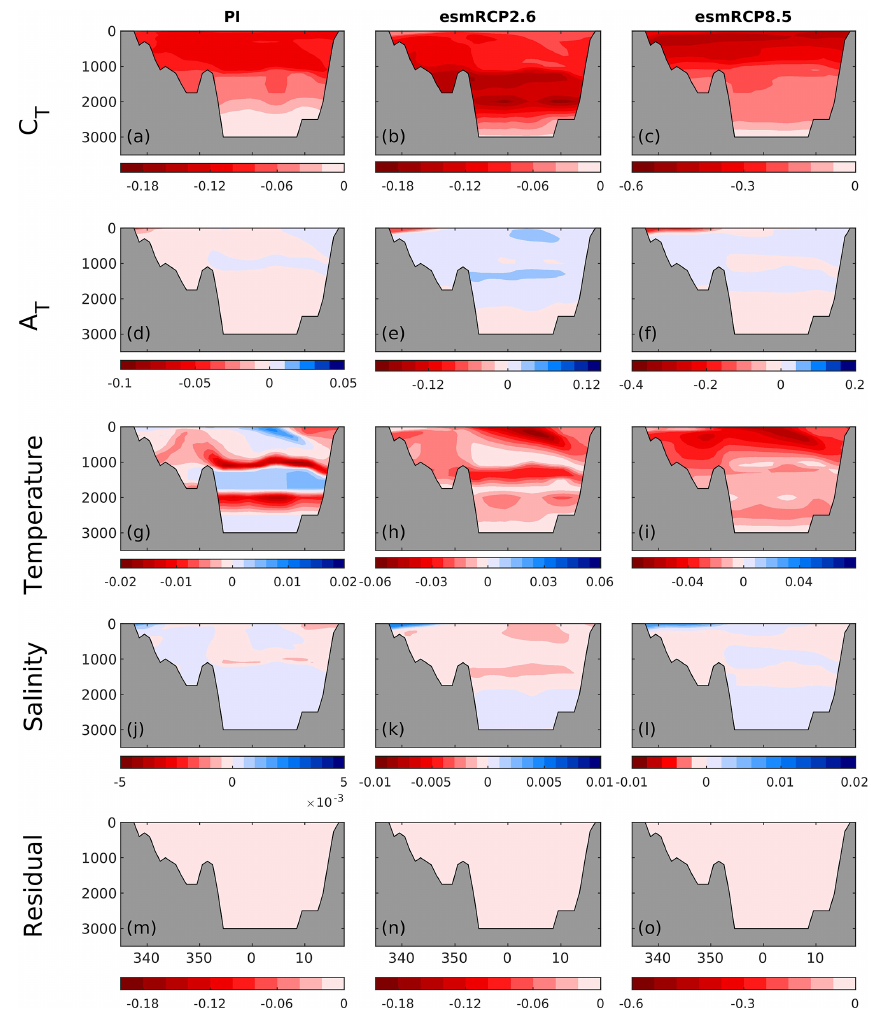
Figure 16. Contribution of modeled changes in surface temperature, salinity, C T , and A T to the change in pH between 1850–1859 and 1996–2005 (PI) and 1996–2005 and 2090–2099 (esmRCP2.6 and esmRCP8.5) at the depth section at 70 ◦ N, as shown in Figs. 6 and 10. The residual indicates the difference between the total change in pH, calculated as the sum of the trends associated with these four driving factors, and the actual change shown in Figs. 6 and